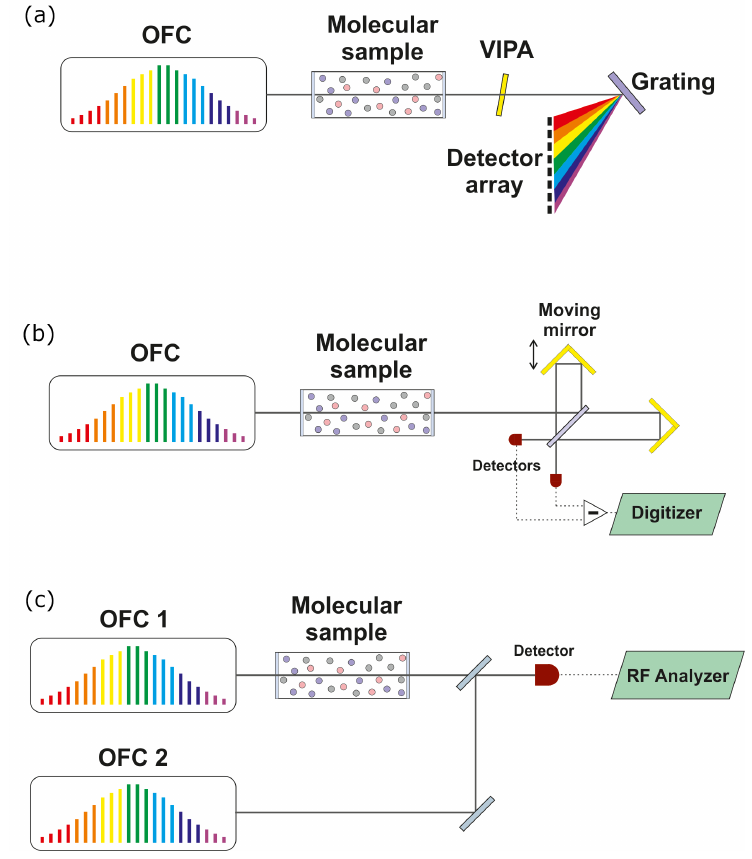
Figure 1. Most used direct frequency comb spectroscopy (DFCS) schemes. ( a ) Frequency comb spectrometry with a disperser for absorption measurements. Here, the optical frequency comb (OFC) light, focused in a line, illuminates the virtual image phased arrays (VIPA) etalon; different VIPA orders are then separated through subsequent dispersion by a classical grating. The final output is detected by a charge-coupled device (CCD) array where each pixel is illuminated by an OFC mode. ( b ) Frequency comb Fourier transform spectroscopy with a scanning Michelson interferometer. ( c ) Dual-comb spectroscopy with two phase-locked OFCs, with one comb interrogating the sample and the other acting as a local oscillator. Here, both the absorption and the dispersion of the sample can be measured. Adapted from [6].